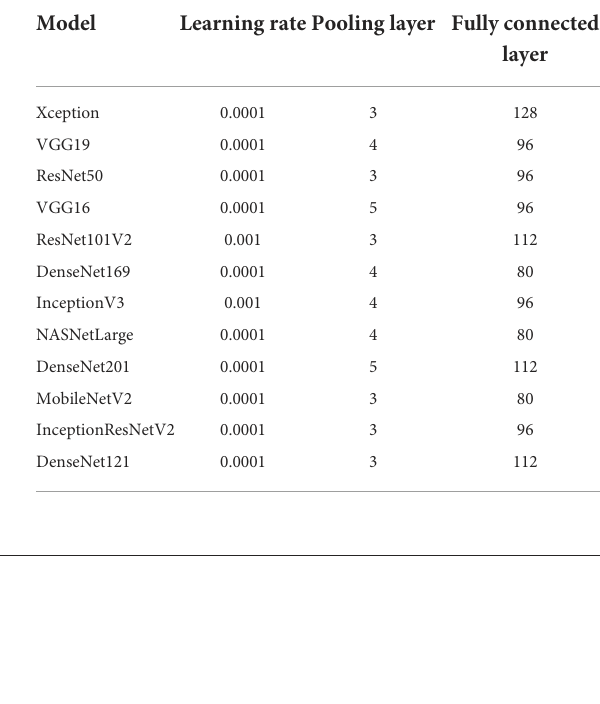
TABLE 4 Training parameters for the models with data augmentation.